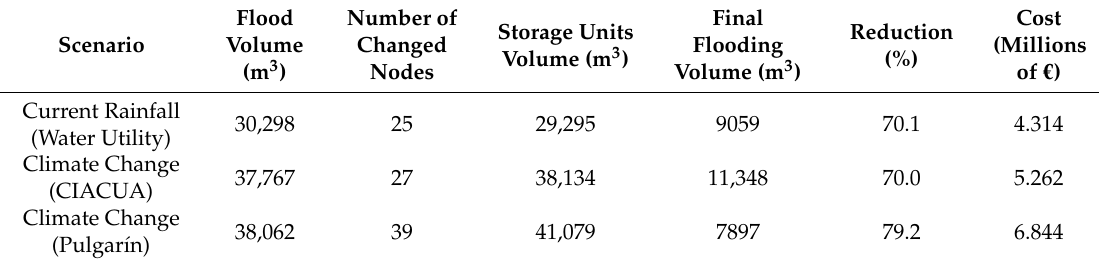
Table 3. Results for the Southern Chic ó Network using OptiTank under di ff erent rainfall